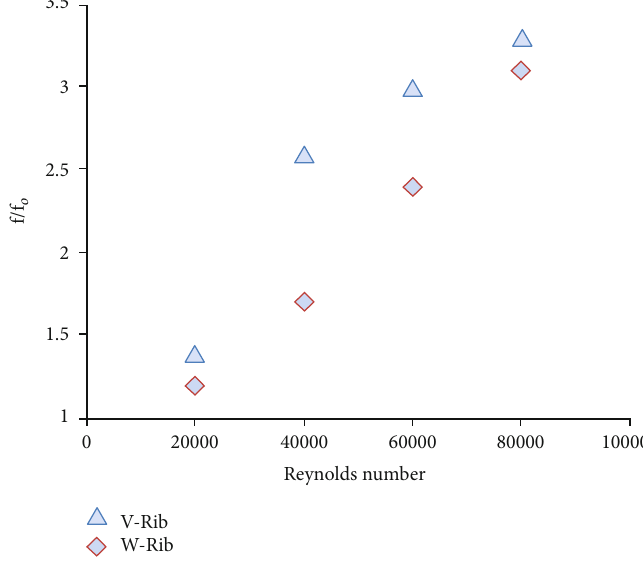
Figure 10: Normalized friction factor